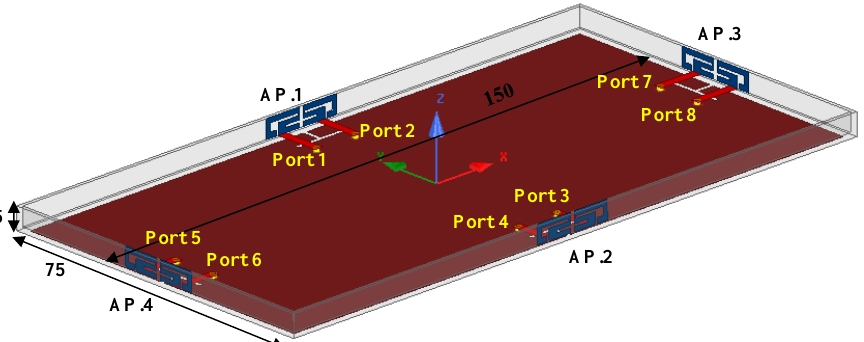
Figure 17. The overall structure of the discussed eight-port AP system.